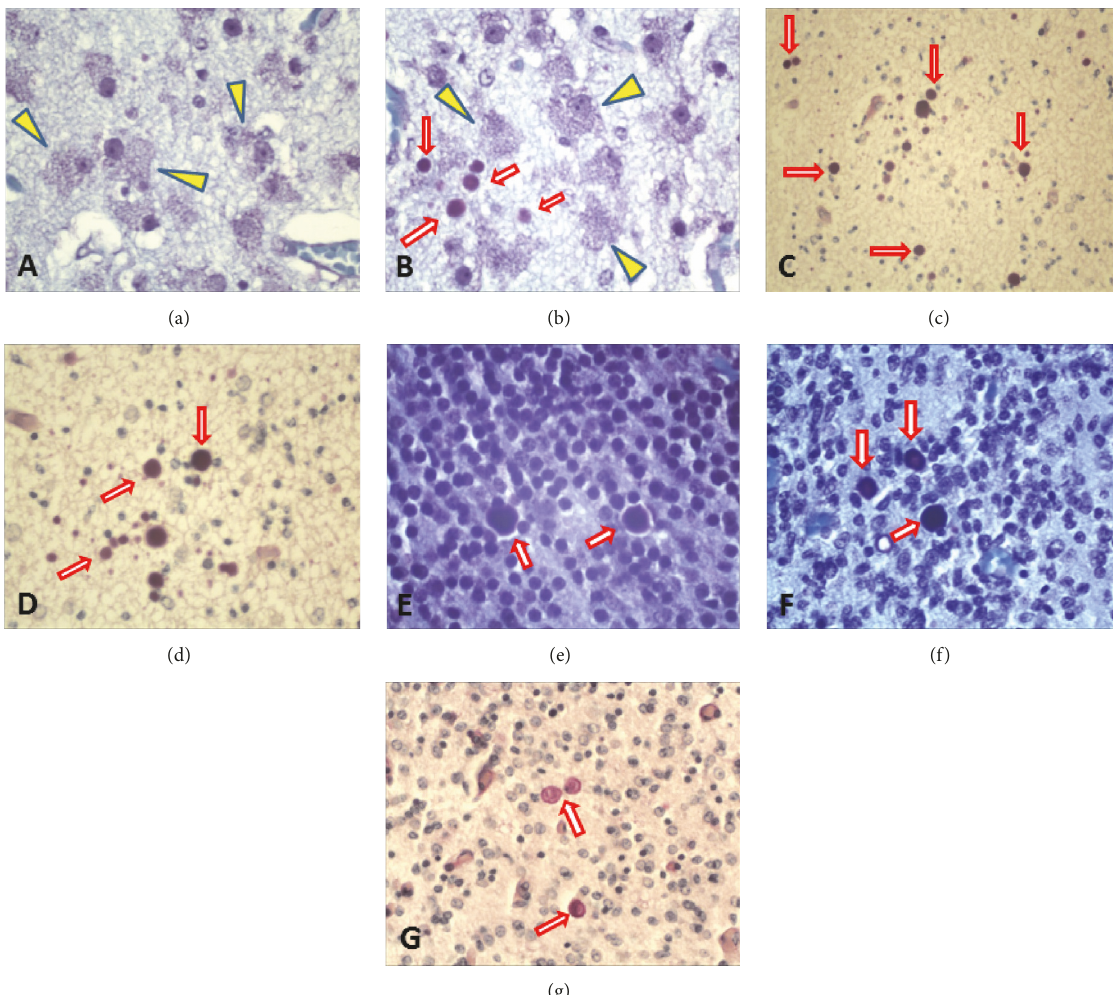
Figure 2: Major neuropathological findings in our case of Sly disease. ((a) and (b)) Histopathological sections from the brain showing numerous neuronal cells with remarkably foamy/vacuolated perikaryonal cytoplasm (arrow-heads; yellow) in the striatum of this 25-year-old fetus. Note also the presence of PGBs (arrows in (b)) in the neuropil. (b), (c), (d), (e), (f), and (g) illustrate the histomorphological appearance and staining characteristics of the many PGBs (some of which indicated by arrows) detected in various brain structures of this fetus, namely, the incipient cerebral white matter ((c) and (d)), the developing cortical plate of the neocortex (e), the telencephalic periventricular germinal zone (f), the striatum (b), and the developing cerebellum (g). This figure, besides, shows that at all levels of the brain, all PGBs appear to be deposited in the neuropil, and none actually look clearly intracellular with any of the various histopathological techniques we employed ((c), (d), (e), (f), and (g)). ((a) through (g)) Light microscopic photographs, Cresyl-violet (Nissl) staining ((a), (b), (e), and (f)), Hematoxylin-Eosin staining (g), and Periodic Acid-Schiff/D-amylase (PAS-D) staining ((c) and (d)). Original magnification: × 400 ((a), (b), (d) and (f)), × 250 (c), × 500 (e), and × 320